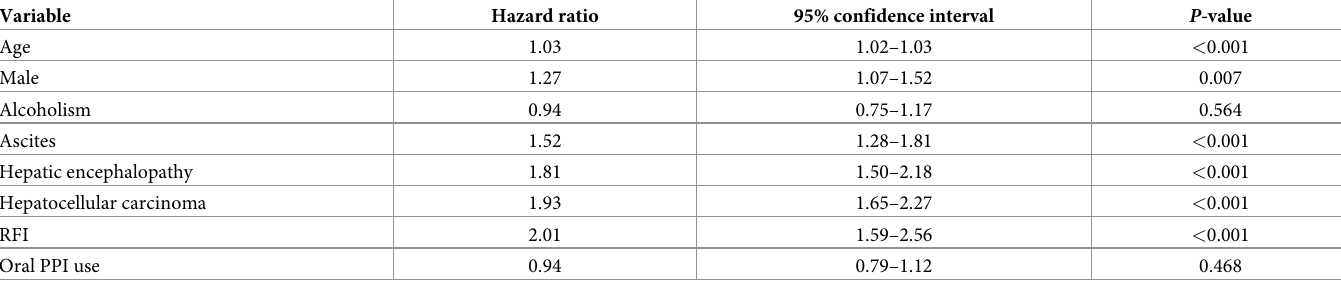
Table 2. Adjusted hazard ratios of the risk for 30-day mortality of cirrhotic patients with pneumonia without active gastrointestinal bleeding.